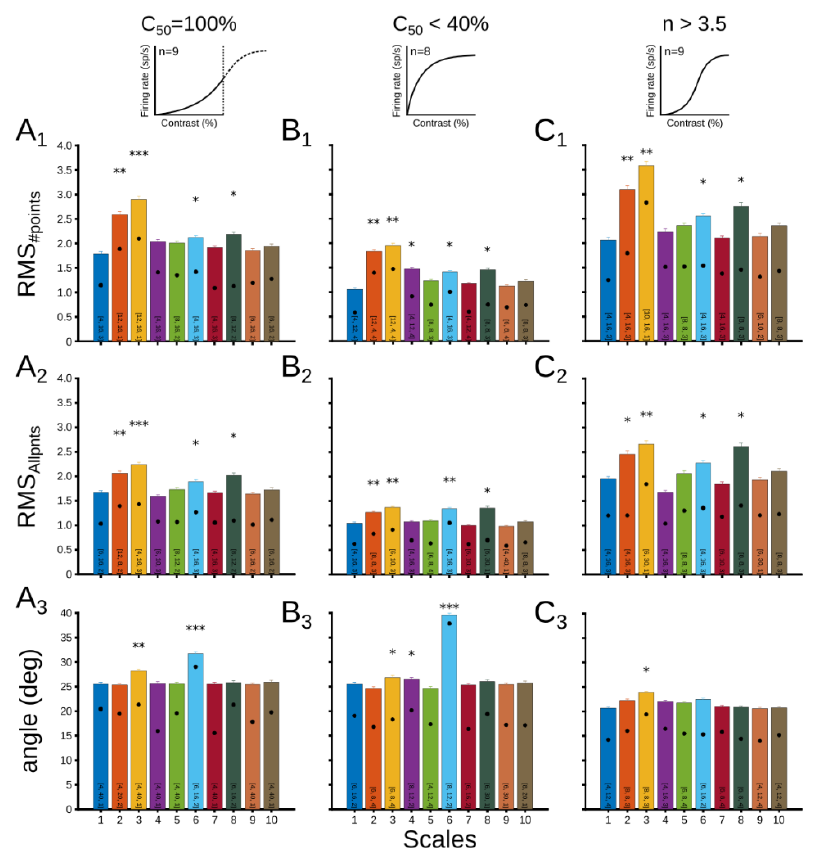
Figure 8. Particular cases of CRF across scales. ( A ) CRFs with C 50 = 100%, ( B ) CRFs wih C 50 < 40%, ( C ) CRFs with n > 3.5. Average errors for ( 1 ) RMS #points , ( 2 ) RMS Allpnts , and ( 3 ) angle difference between vectors. Each bar shows the pattern that minimizes most errors, and the black dot shows the position in the average range. * p < 0.05; ** p < 0.01; *** p < 0.001.